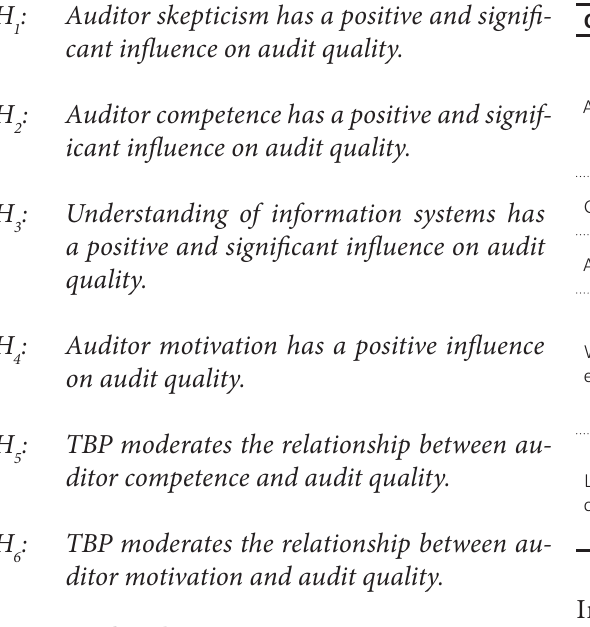
Table 2. Description of the